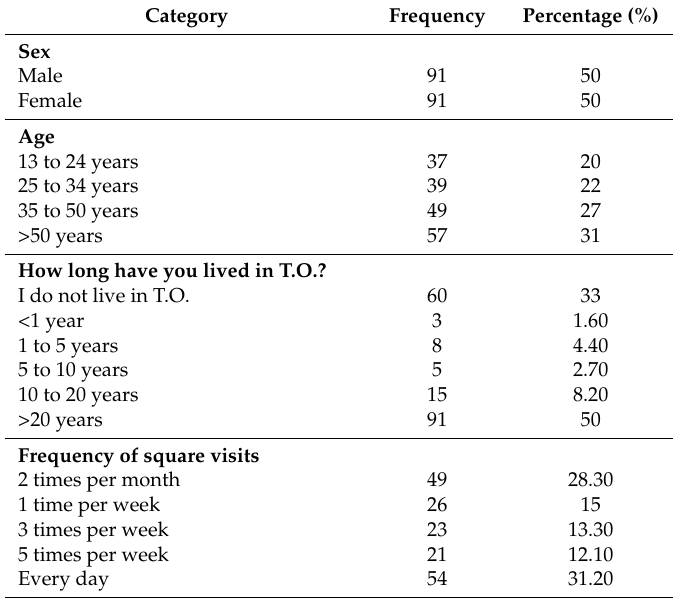
Table 1. Demographic characteristics of respondents interviewed in Teofilo Otoni, Minas Gerais, Brazil about the presence of brown-throated sloths in Tiradentes Square (we used the valid percentage as data, since some people did not answer all questions). T.O. = Teofilo